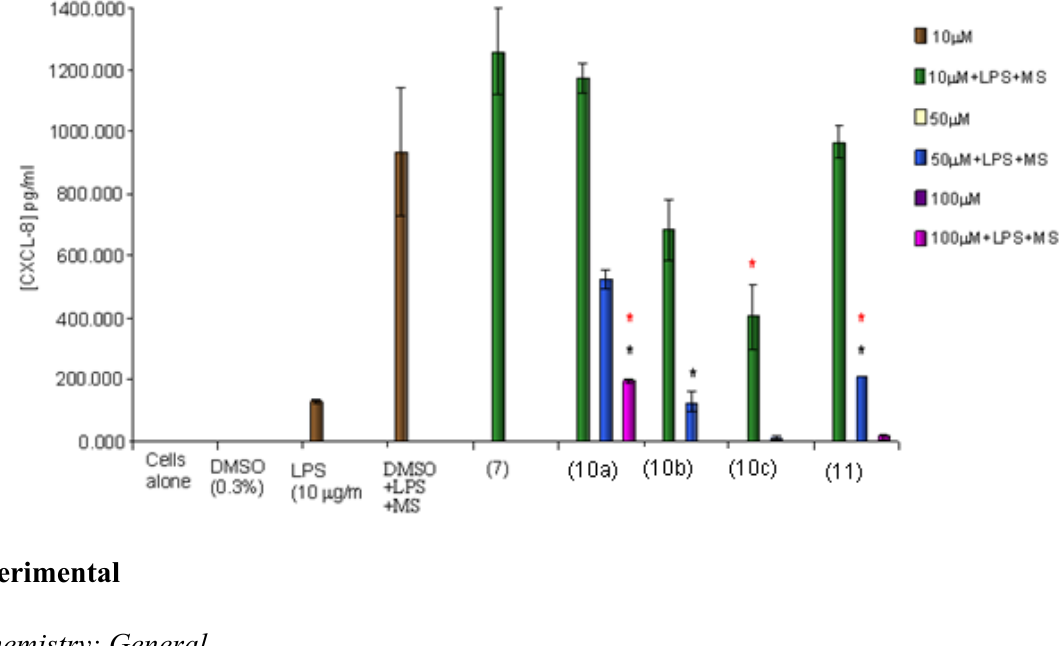
Figure 10. The effects of curcumin ( 7 ) and thiophene curcuminoids 10a – c , 11 on the production of CXCL-8 in MS and LPS-induced CACO-2 cells using ELISA assay. Results are presented as mean ± SD. * p < 0.05 compared with DMSO control, * p > 0.05 compared with curcumin control ( 7